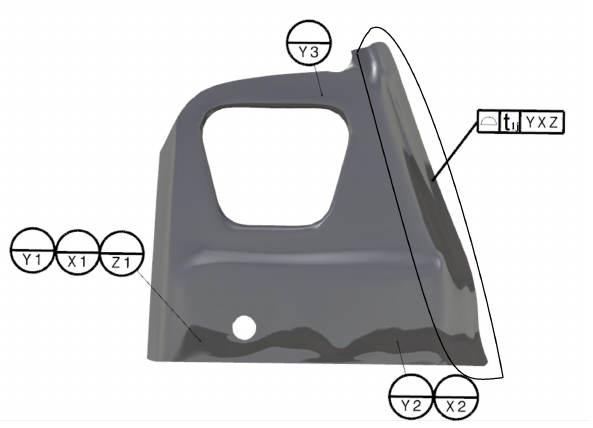
Figure 3. Tolerances of the first part.